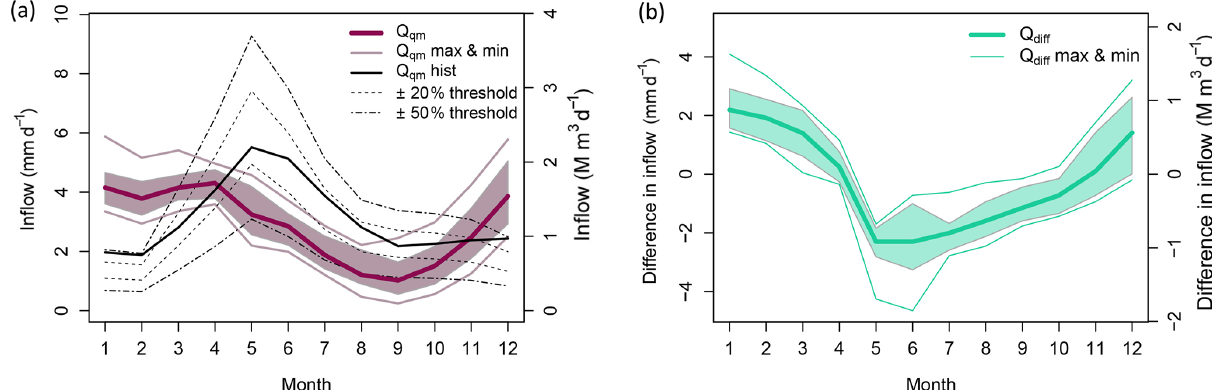
Figure 3. (a) Long-term mean monthly inflow entering the Vernex reservoir for 1980–2009 ( Q qm hist) and for 2070–2099 ( Q qm , RCP8.5). The mean (solid lines) and likely range (shaded areas) are shown, where the likely range represents two-thirds of the simulations. The two thresholds are based on the mean of the simulations forced by observed climate data ( Q ref over the period from 1980 to 2009). (b) Long-term mean monthly change in inflow (2070–2099 with respect to 1980–2009) for the Vernex catchment.